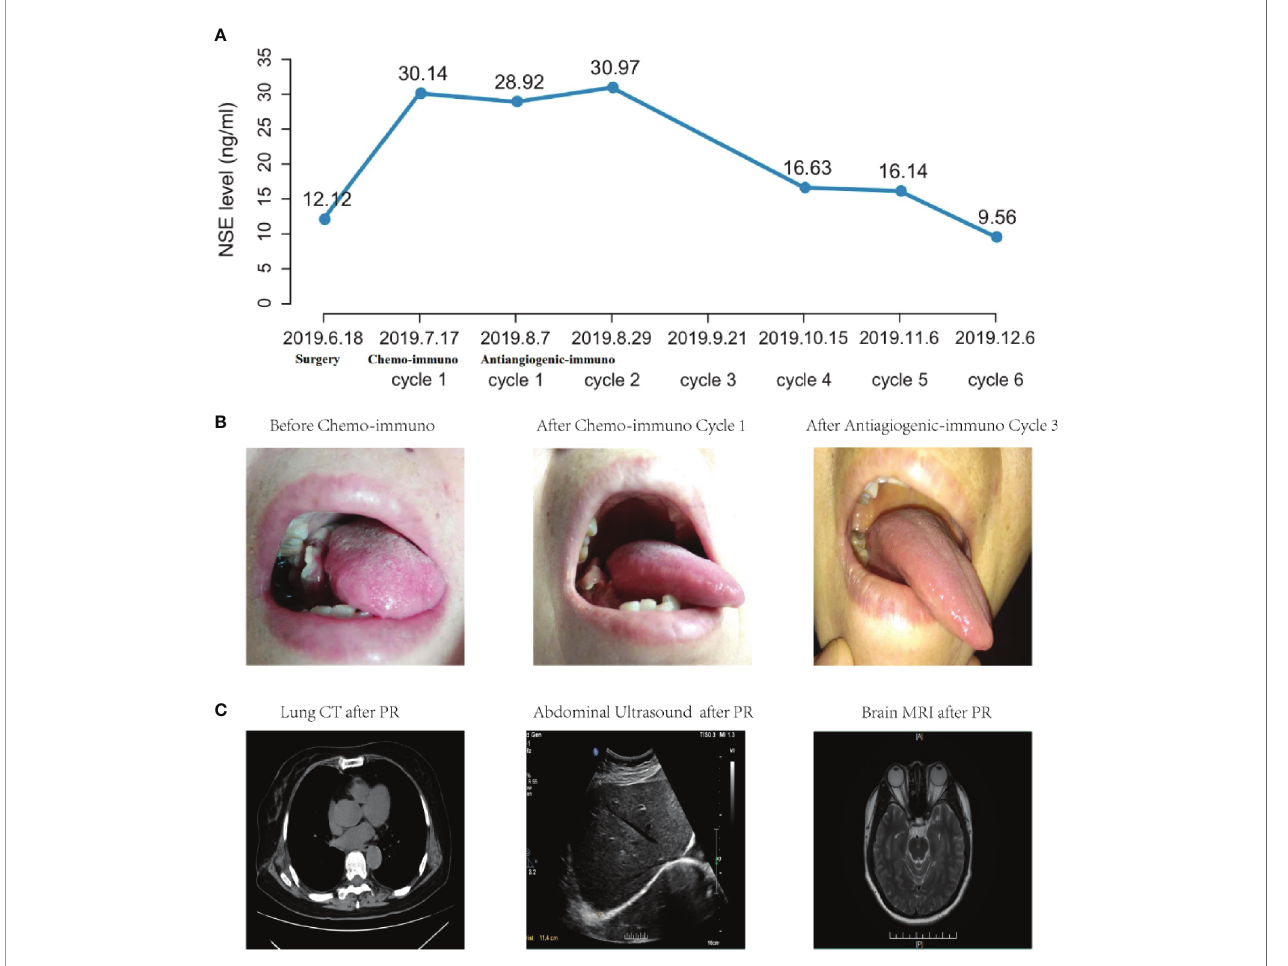
FIGURE 2 | Clinical outcomes of NSE level (A) , mouth metastasis (B) and multiple organs (C) of this LCLC case. NSE level was detected before surgery or before each cycle treatment. After radical surgery, serum NSE level dramatically increased after surgery, and gradually decreased to normal levels after three cycle treatments of antiangiogenic-immunotherapy. In addition, mouth lesion appeared after surgery and disappeared after combination antiangiogenic-immunotherapy. Besides, there were no abnormity in multiple organs and PR lasted for more than 12